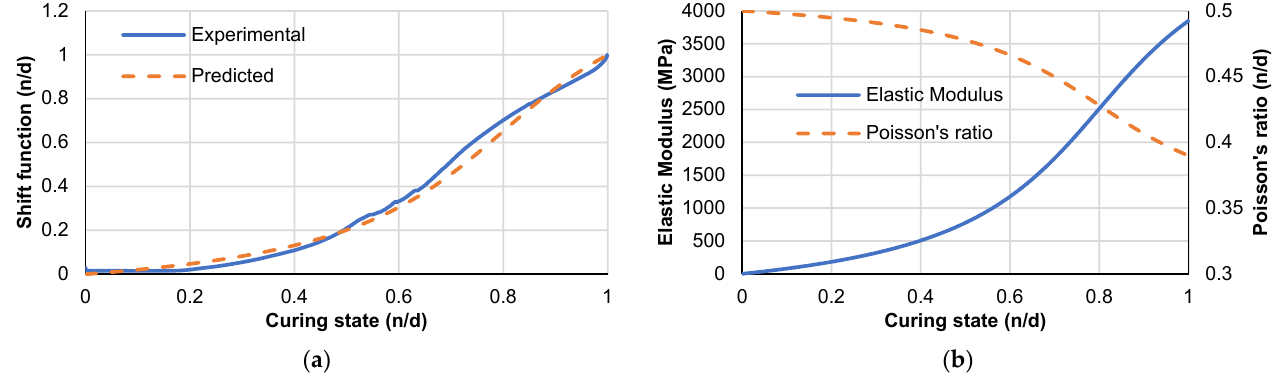
Figure 5. ( a ) Shift function for storage modulus and ( b ) Elastic properties evolution with curing